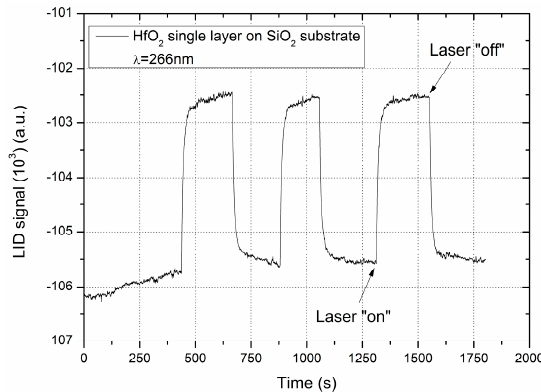
Figure 4. Experimental results for the measurement of a single HfO 2 layer onto a fused silica substrate at the laser wavelength of 266 nm.